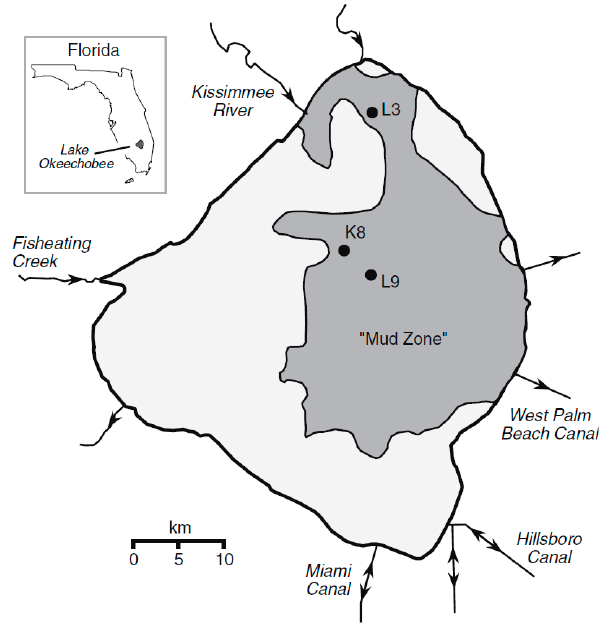
Figure 8. Map of Lake Okeechobee showing the locations of cores studied by Schottler and Engstrom in 2003 [34].